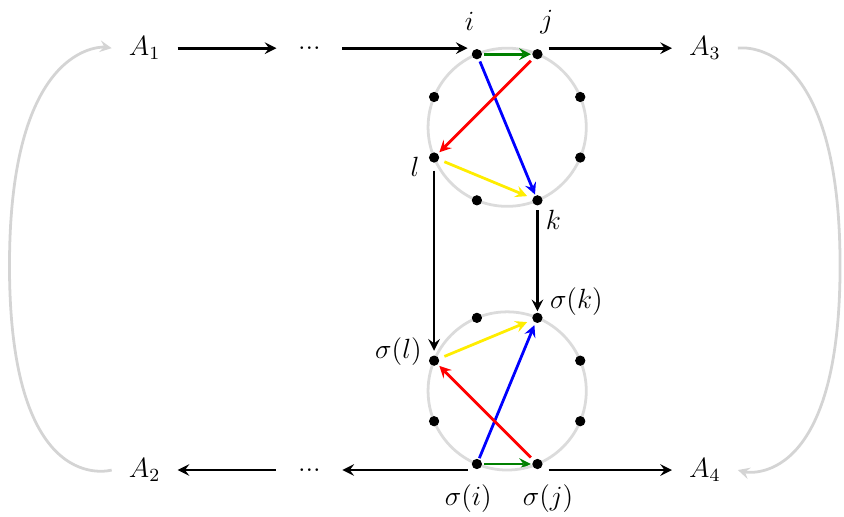
Figure 11. Insertion of an extra set of rungs in an oriented ladder. Not all internal threads in the interactions nor all rungs have been drawn so as to not clutter up the (cid:12)gure. By (cid:13)ipping two arrows, each corresponding to q (cid:0) 1 interchanges of indices in a matrix (cid:10) ab or (cid:10) , we get an oriented ab